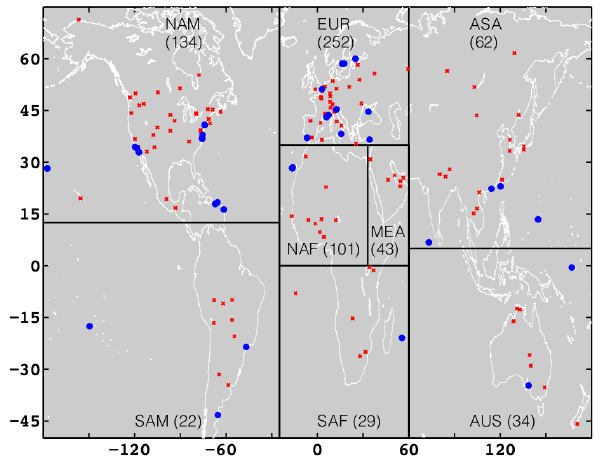
Fig. 5. Regional boundaries and locations of the 147 AERONET sites used in this study. The blue dots indicate AERONET sites where CALIPSO retrieves the marine aerosol subtype for all de- tected aerosol layers in the column during at least one closest ap- proach. Number of closest approaches in North America (nam), Eu- rope (eur), Asia (asa), South America (sam), Northern Africa (naf), Middle East (mea), Southern Africa (saf), and Australia (aus) are shown in parentheses.